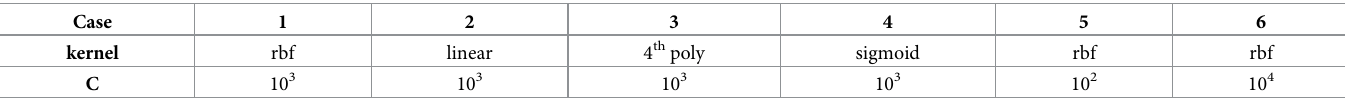
Table 3. Cases at different parameter